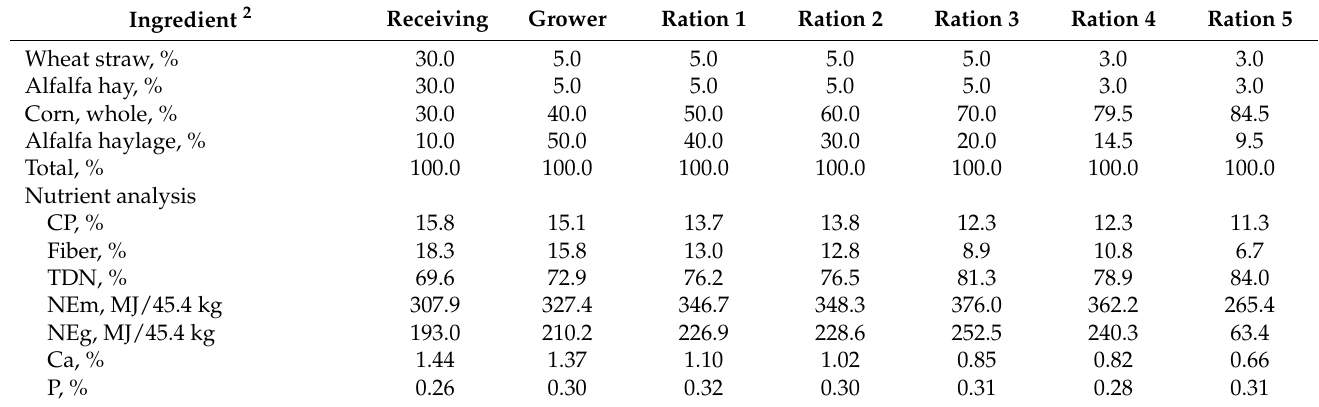
Table 1. Beef steer feedlot diet composition and nutrient analysis (DM) 1